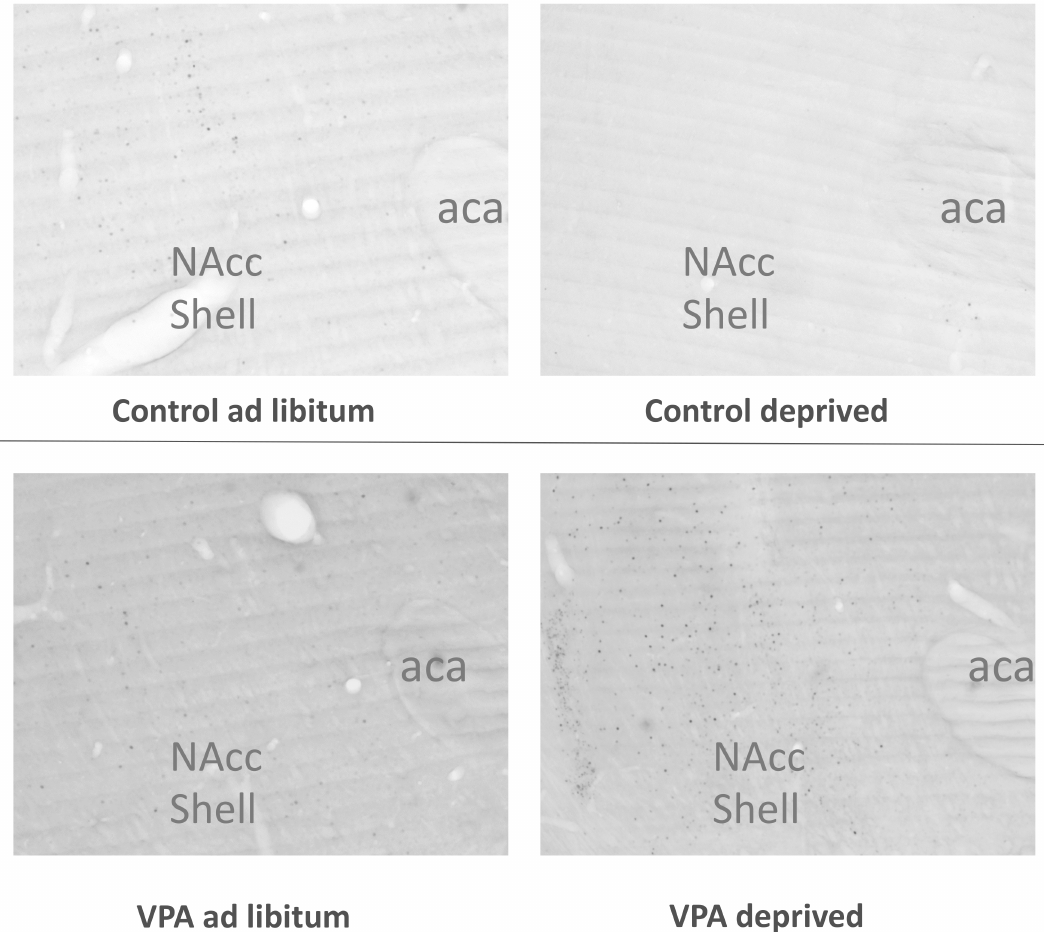
Figure 9. Photomicrographs depicting hypothalamic c-Fos IR in the Nacc Shell. Surprisingly, unlike in healthy controls, in VPA fasted rats compared to ad libitum-fed VPAs, we did not see changes between the fed and deprived state in the PVN or SON. On the other hand, ARC c-Fos IR increased in deprived VPA rats (F = 1.317, df = 18, p = 0.0032). Furthermore, we noted an increase instead of a decrease in the Nacc Shell and CeA c-Fos IR (F = 2.453, df = 17, p = 0.035 and F = 30.994, df = 17, p = 0.022, respectively; Figures 6–9). RtPCR analysis of gene expression profiles in the hypothalamus and brain stem in healthy controls revealed that healthy food-deprived rats had upregulated hypothalamic AgRP and MOR expression compared to fed controls (F = 1.157, df = 17, p = 0.000287 and F = 1.498, df = 15, p = 0.000295, respectively), while hypothalamic OXT mRNA expression was decreased in deprived animals (F = 1.316, df = 15, p = 0.0397). Brainstem gene ex- pression analysis revealed an increase in OXTR mRNA levels in unfed animals (F = 1.422, df = 15, p =